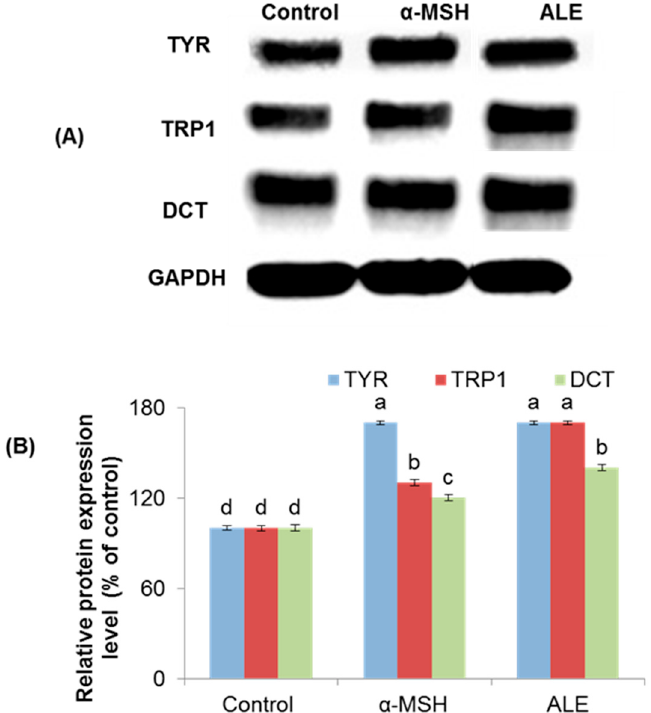
Figure 3. Effect of argan leaves extract (ALE) on melanogenic enzymes TYR, TRP1, and DCT expression level, determined by Western blot analysis. Western blot bands ( A ) and the corresponding densitometric values ( B ) are presented. B16 melanoma cells were treated without (Control) or with α -MSH (0.2 µM) or ALE (30 µg/mL) and incubated for 72 h. Values are mean ± SD derived from three independent experiments; different letters on the histograms indicate significant difference between treatments ( p ≤ 0.05) (ANOVA Tukey’s test). The protein bands intensities of TYR, TRP1, and DCT were obtained using Li-COR Software.